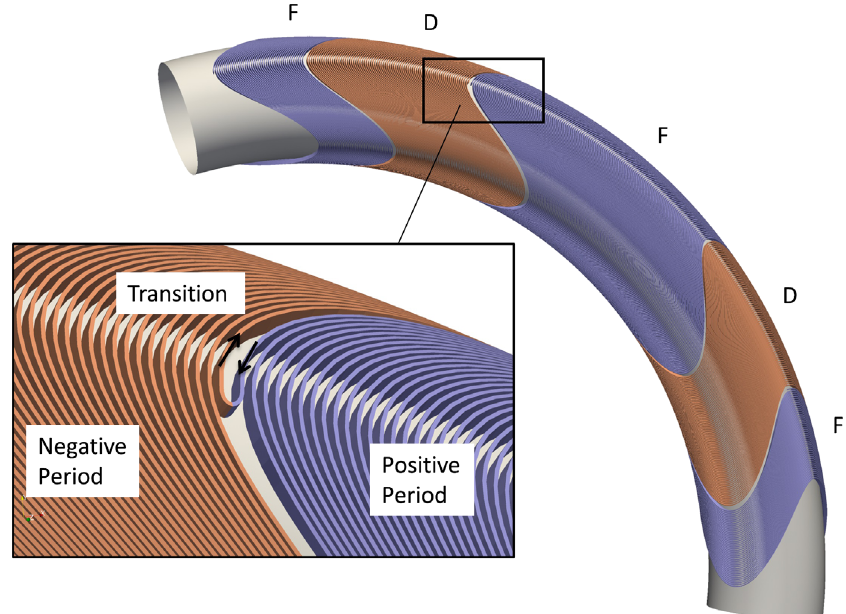
FIG. 3. A single alternating focusing quadrupole layer (corresponding to Layer 1 in Fig. 2) is shown with five sections (FDFDF). The transition scheme between sections of opposite axial period is enlarged with the current direction indicated. This approach allows for the coil to be generated with one continuous winding, where the relative integral strength of the sections can be tuned by adjusting the number and location of the transition